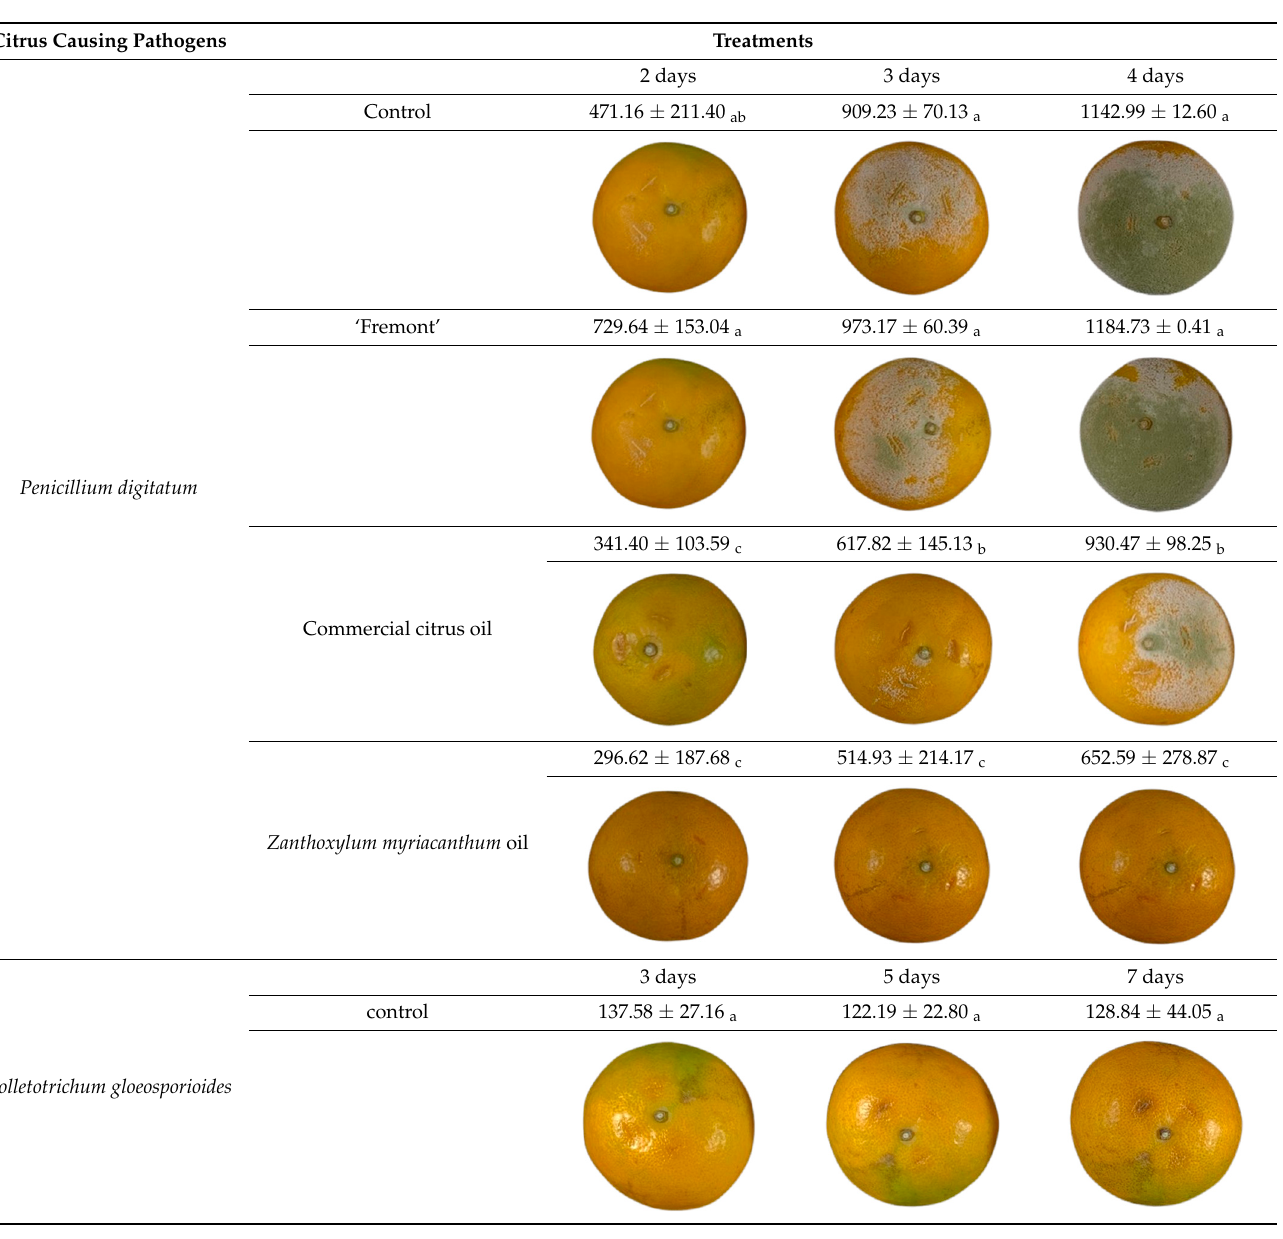
Table 4. The lesion size (mm 2 ) of pathogens ( Penicillium digitatum and Colletotrichum gloeosporioides )